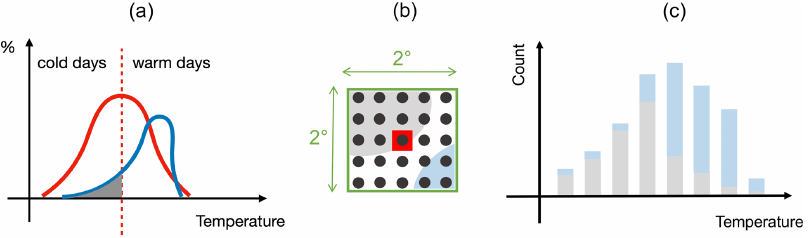
Figure 1. Schematics of the methodological aspects. (a) Probability distributions of daily mean 2m temperature for all days (red) and wet days only (blue) at a particular grid point. The vertical dashed red line denotes the median of the T distribution for all days, and the grey shading marks the fraction of wet days below this median. (b) A 2 ◦ × 2 ◦ box is used to attribute weather systems (grey and blue shading) to precipitation at a grid point (red square). The black points symbolize each grid point in the box. (c) Frequency of occurrence of the blue and grey weather systems as a function of wet day